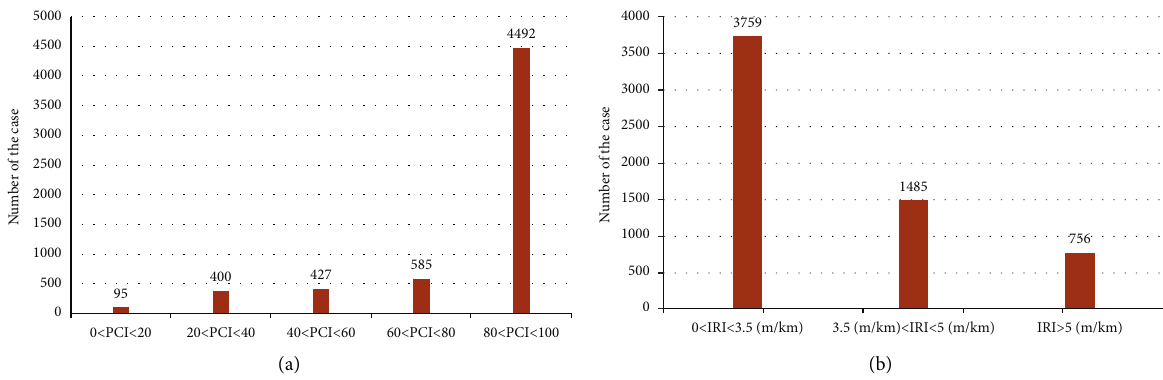
Figure 4: Frequencies of the cases versus (a) PCI ranges and (b) IRI